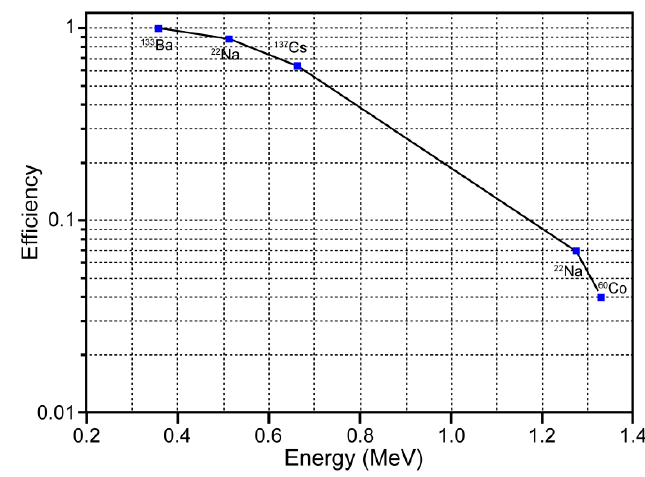
Figure 5. Full-energy peak efficiency in the 0.356–1.3 MeV energy range.